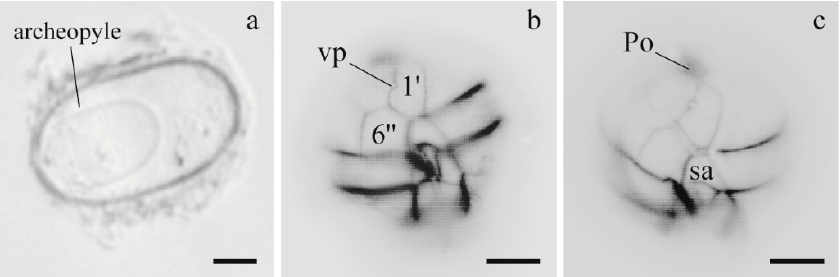
Figure 3. Light micrographs of Alexandrium tamarense cyst and cells (UNISS5 strain), stained with Calcofluor and observed using UV fluorescence. ( a ) empty cyst showing the shape of archeopyle; ( b , c ) ventral views showing the ventral pore (vp) in the 1 ′ plate, the wide 6 ′′ plate and the connection between the 1 ′ plate and apical pore plate (Po). Scale bars 10 µm.